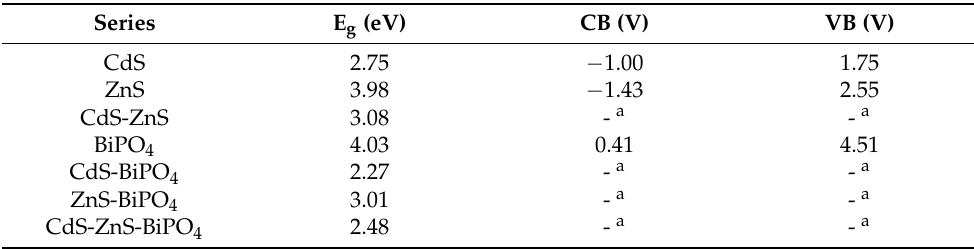
Table 1. Measured energy gap ( E g ), the level of conduction-band (CB) edge, and valence-band edge (VB) for the prepared samples.